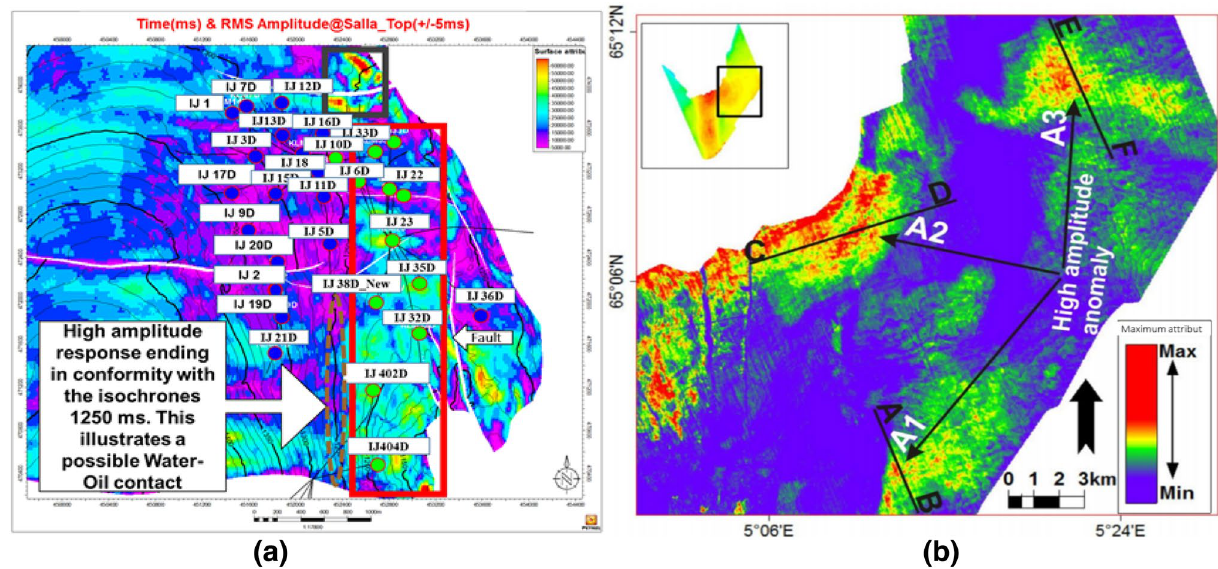
Fig. 11 a IJ SaIIa maximum amplitude map; b RMS amplitude map ( ± 30 ms) Naust A (Tanveer